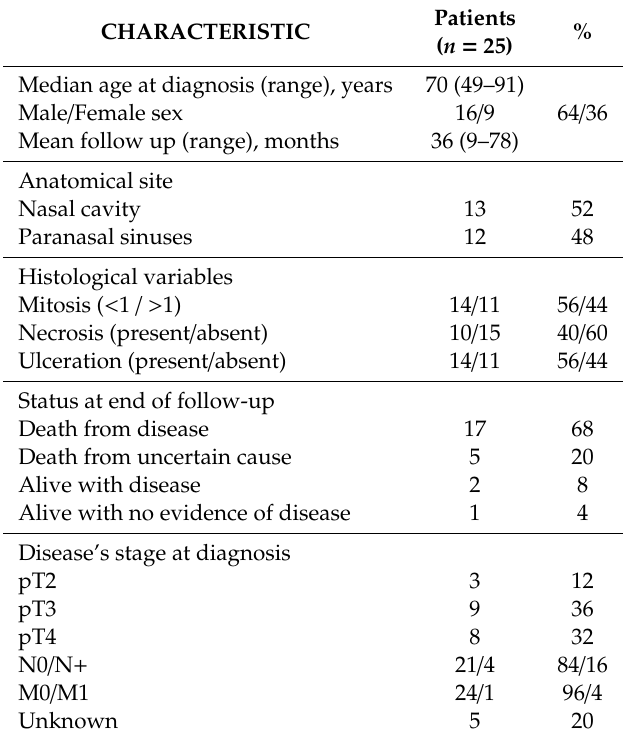
Table 1. Clinical and pathological characteristics of